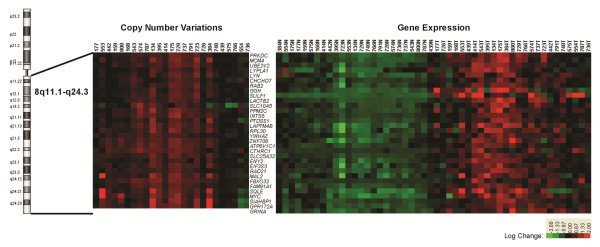
Correlation between copy number gains and overexpression of 31 genes at 8q11.1-q24.3. The genes were arranged in chromosomal order (p → q). An unsupervised hierarchical clustering of 50 gastric tissues with 32 genes overexpressed in gastric cancer samples (T) and underexpressed in matched adjacent noncancerous samples (N) revealed two distinct clusters (on the right). The genes included MCM4, PRKDC, UBE2V2, LYPLA1, LYN, CHCHD7, RAB2, GGH, SULF1, LACTB2, SLC10A5, PTDSS1, INTS8, LAPTM4B, PPM2C, RPL30, ATP6V1C1, SLC25A32, YWHAZ, ZNF706, CTHRC1, ENY2, RAD21, EIF3S3, MAL2, FAM91A1, FBXO32, SQLE, MYC, GPR172A, SIAHBP1, and GRINA (lack of aCGH data).